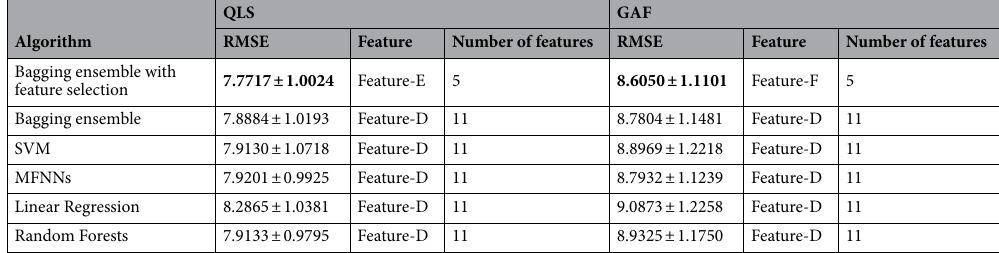
(Table 2; the Feature-D, Feature-E, and Feature-F datasets) to predict the QLS and GAF of schizophrenia using the cognitive function scores. Note that the Feature-D set included the 11 cognitive function scores. memory, and social cognition) from the 11 cognitive function scores, where these 5 chosen features comprised the Feature-E dataset. soning and problem solving) from the 11 cognitive function scores, where these 5 selected features comprised the Feature-F dataset.